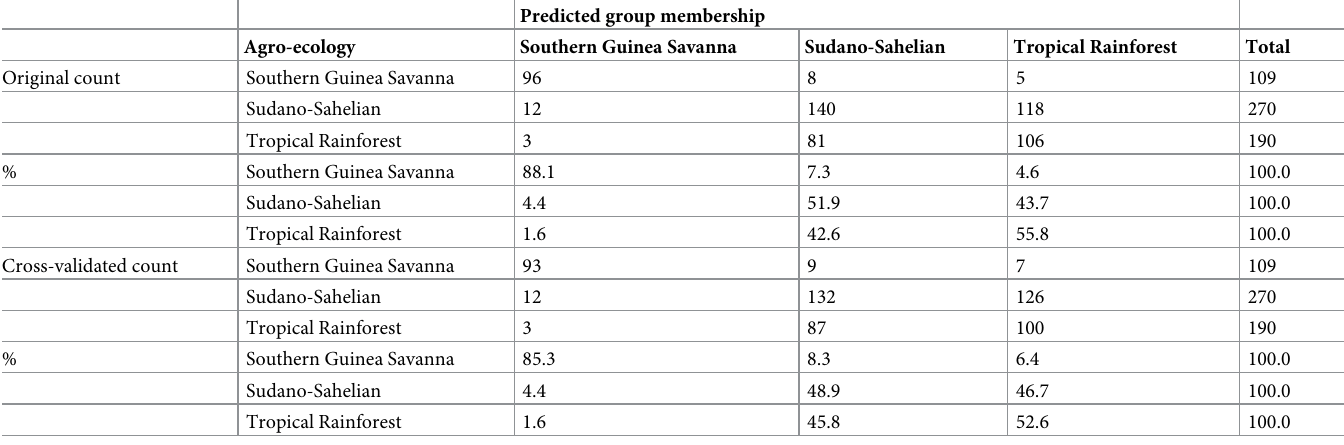
Table 7. Assignment of birds to the three agro-ecological